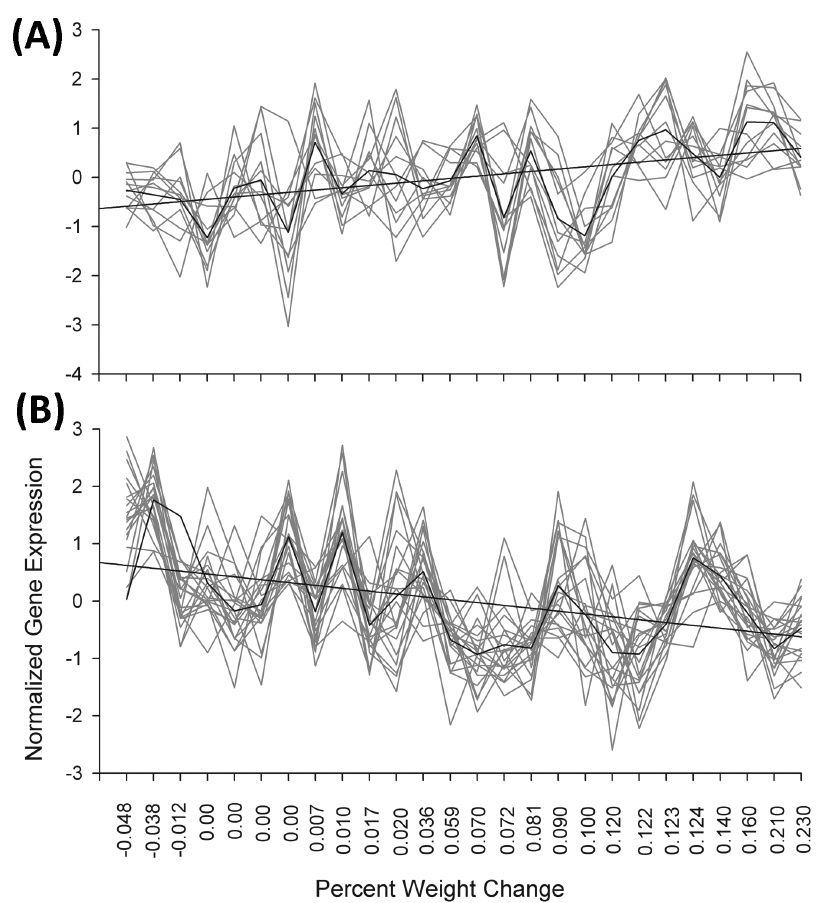
Figure 1. Genes correlated with relative weight change. A set of 12 and 21 obesity related genes that are positively (A) and negatively (B) correlated with relative weight change, respectively. Each line represents the mean normalized expression value (vertical axis) for a given gene across 26 kidney transplant recipients ordered with respect to weight loss/gain (horizontal axis) at 6 months after transplantation. doi:10.1371/journal.pone.0059962.g001 PLOS ONE |